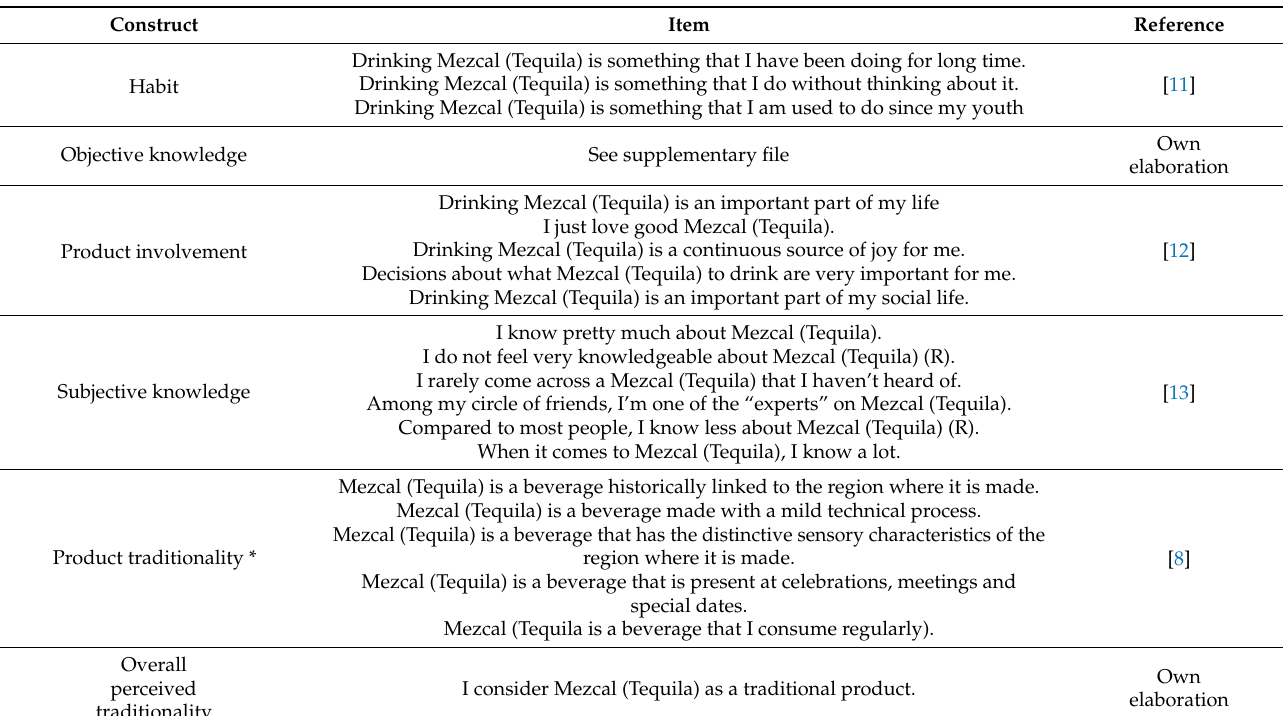
Table 2. Constructs, items and dimensions for the concept of product traditionality evaluated in the